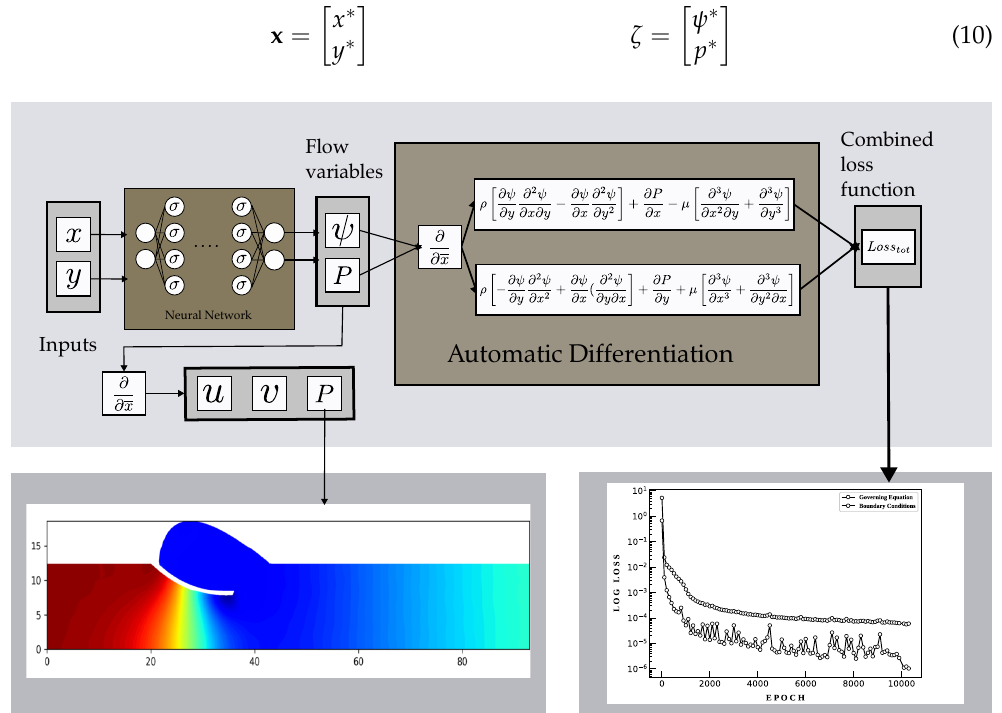
Figure 3. Simplified overview of the physics informed neural network (PINN)